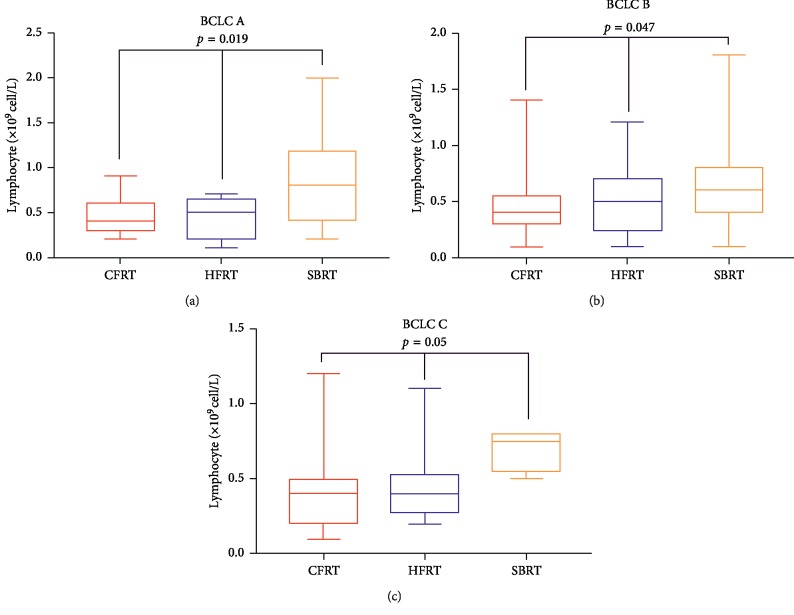
Comparison of lymphocyte nadir among CFRT, HFRT, and SBRT in patients with BCLC stage A, p=0.019 (a); BCLC stage B, p=0.047 (b); and BCLC stage C, p=0.05 (c), respectively.